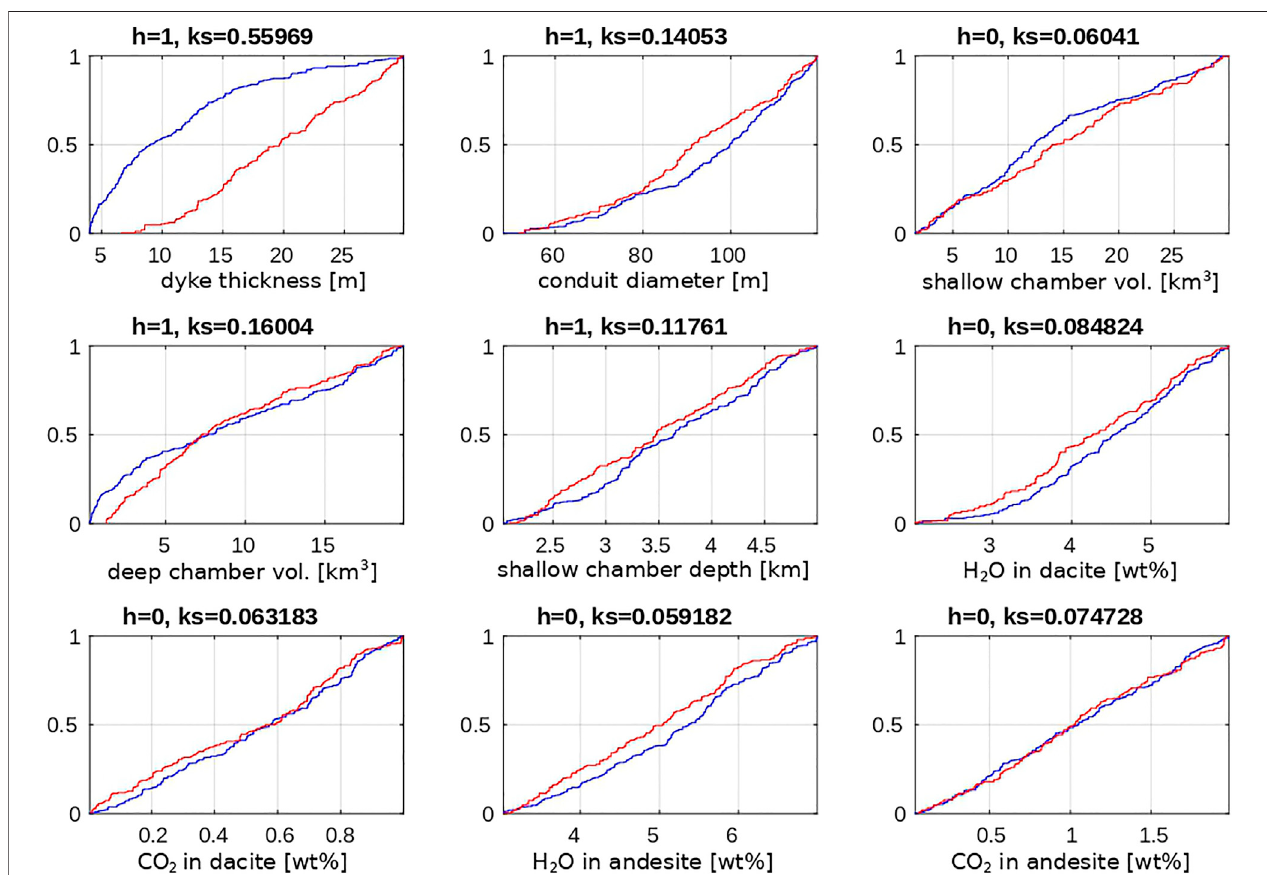
FIGURE 4 | Regional analysis results for eruption magnitude less than (blue lines) or larger than (red lines) the value of 6.5. See Figure 3 for the interpretation.